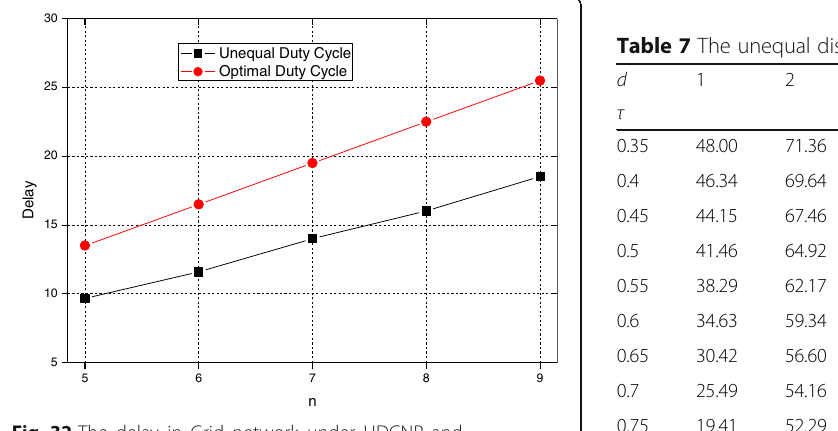
Fig. 32 The delay in Grid network under UDCNP and